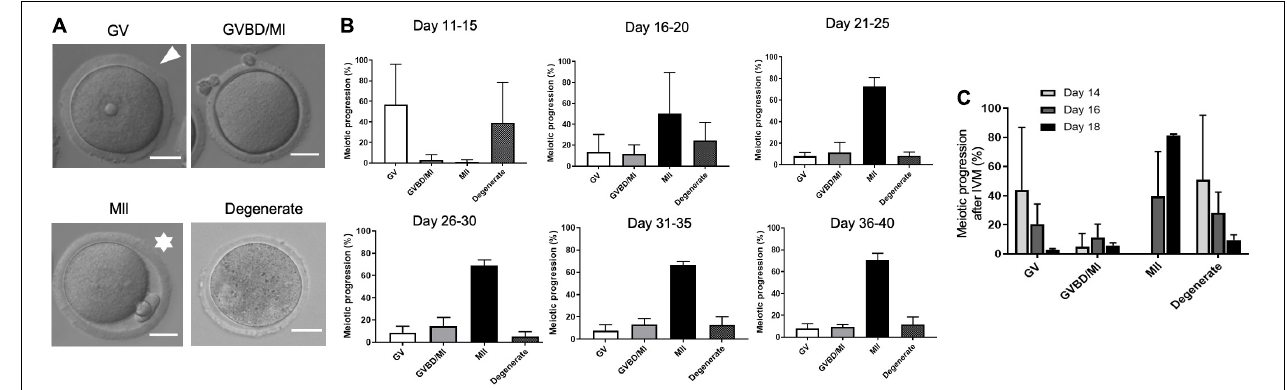
FIGURE 3 | Age-dependent acquisition of oocyte meiotic competence in mice. (A) The ability of the oocytes in each age cohort to progress through meiosis following in vitro maturation (IVM) was scored according to morphological criteria as visible in the representative transmitted light images. Cells with an intact germinal vesicle (GV; arrowhead) were arrested at prophase I; cells that had extruded a first polar body (asterisks) reached metaphase of meiosis II (MII); cells that lacked a GV or a PB had undergone germinal vesicle breakdown (GVBD) or were at metaphase of meiosis I (MI). Fragmented, lysed, or shrunken cells were classified as degenerated. The scale bars are 25 µ m. (B) Percentage of oocytes isolated from mice that progressed to specific stages of meiosis following IVM was calculated for each age cohort ( n = 34 mice, 4–8 mice per age cohort). (C) Percentage of oocytes isolated from PND 14, PND 16, and PND 18 mice that progressed to specific stages of meiosis following IVM. MII-arrested eggs are first observed on PND 16. PND, postnatal day.